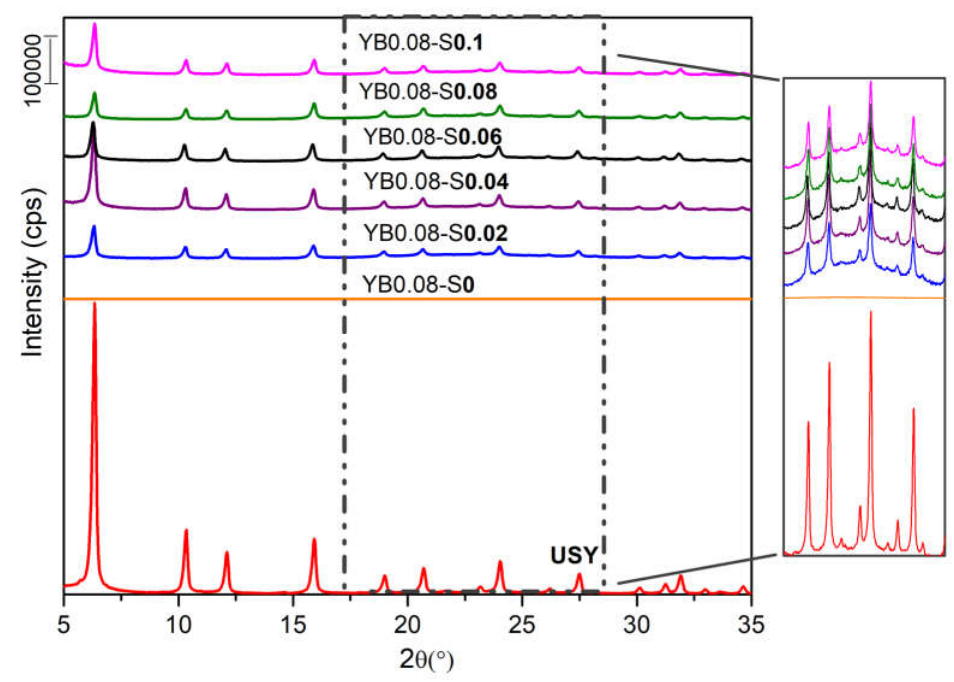
Figure 1. X-ray diffractograms of the samples modified using different concentrations of cetyltrimethylammonium bromide (CTAB).